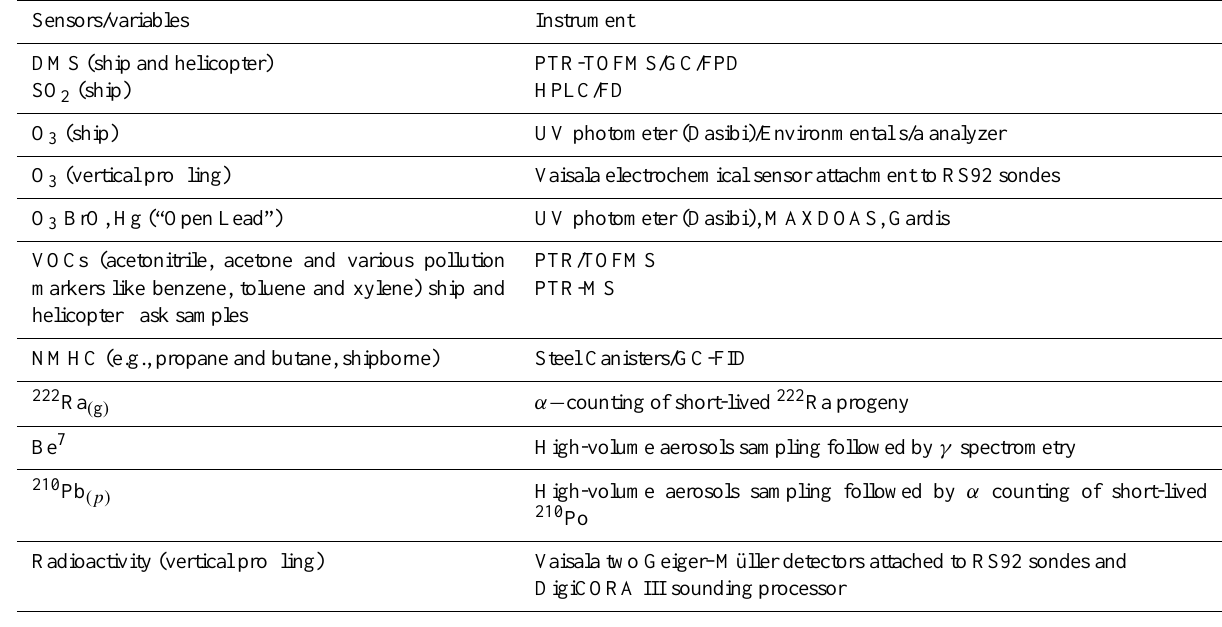
Table A6. Atmospheric chemistry – gases.